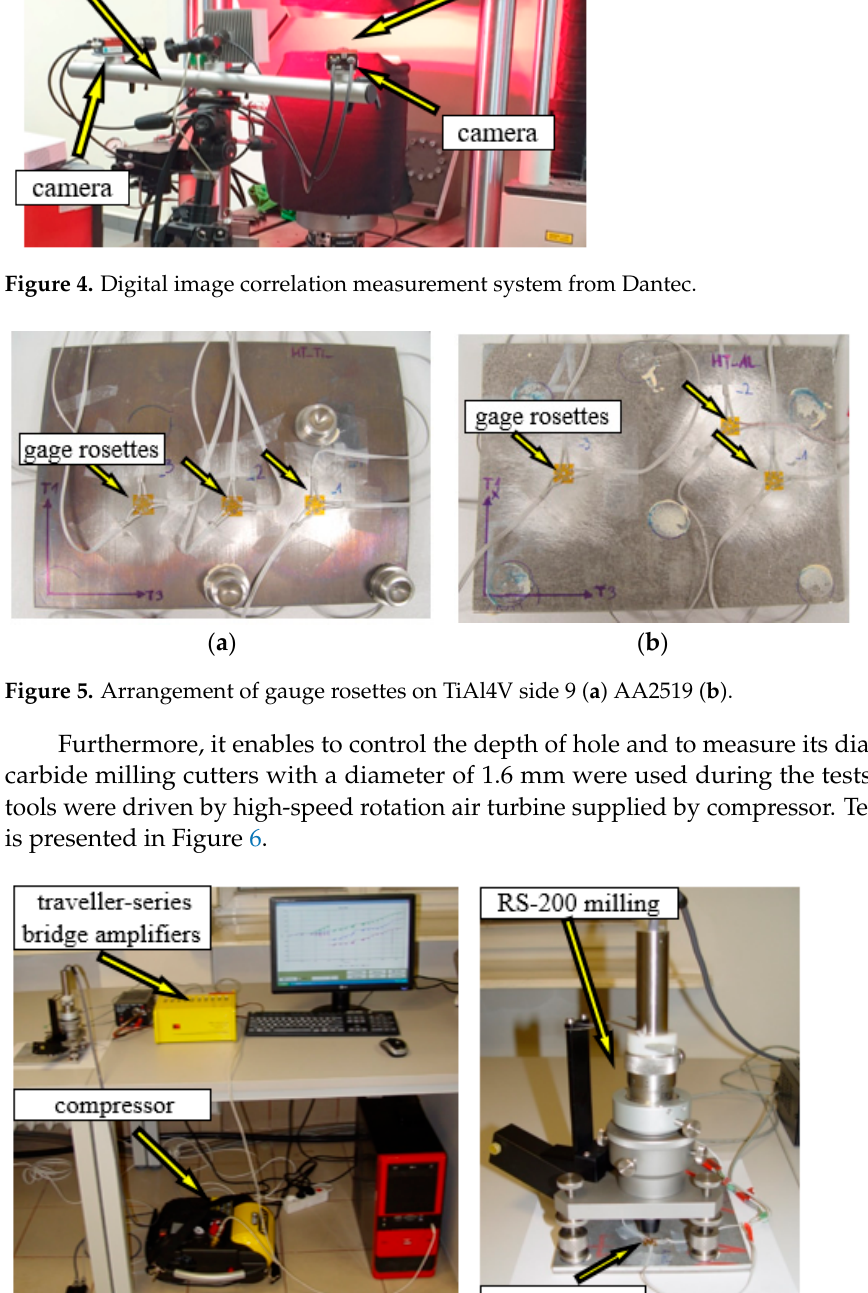
Figure 4. Digital image correlation measurement system from Dantec .